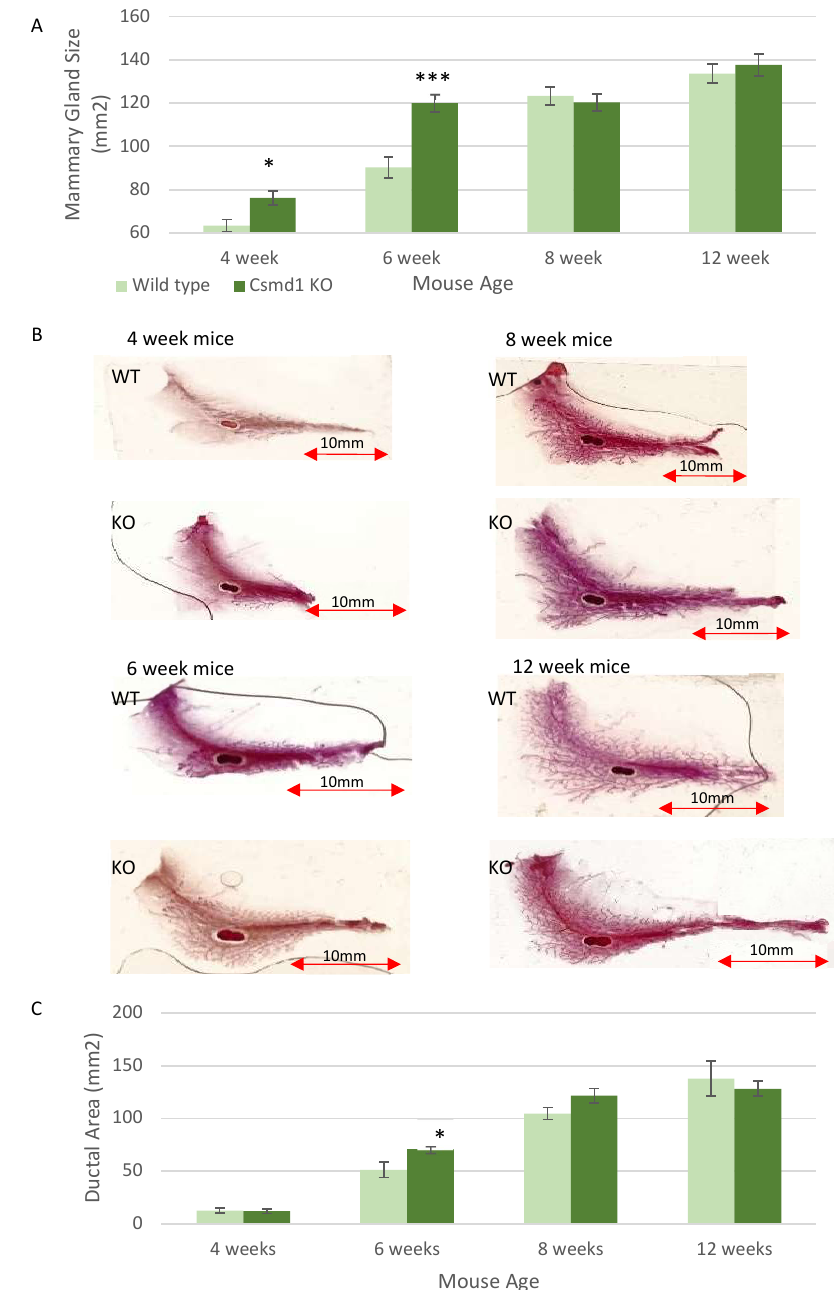
Figure 2. Loss of Csmd1 leads to increased mammary gland size and ductal growth. ( A ) Graph showing the changes in mammary gland size between the WT and Csmd1 KO mice. The area of the abdominal fat pad was measured in each mouse (mm 2 ), showing significant changes at 4 and 6 week (* p < 0.05 and *** p < 0.001). The numbers of animals for each time point included 4-week-old mice ( n = 12: WT; n = 14 KO), 6-week-old mice ( n = 5: WT; n = 11 KO), 8-week-old mice ( n = 7: WT; n = 8 KO), 12-week-old mice ( n = 7: WT; n = 9 KO). ( B ) Whole mount stained mammary glands at all ages (4, 6, 8, 12 weeks) from both WT and KO mice, scale bar 10 mm. The images show the ductal trees within the mammary gland fat pad. ( C ) Graph showing the differences in ductal tree area between the WT and KO mice, (mm 2 ), with significant differences noted at 6 weeks (* p < 0.05). The numbers of animals for each time point included 4-week-old mice ( n = 12: WT; n = 10 KO), 6-week-old mice ( n = 5: WT; n = 10 KO), 8-week-old mice ( n = 7: WT; n = 7 KO), 12-week-old mice ( n = 7: WT; n = 7